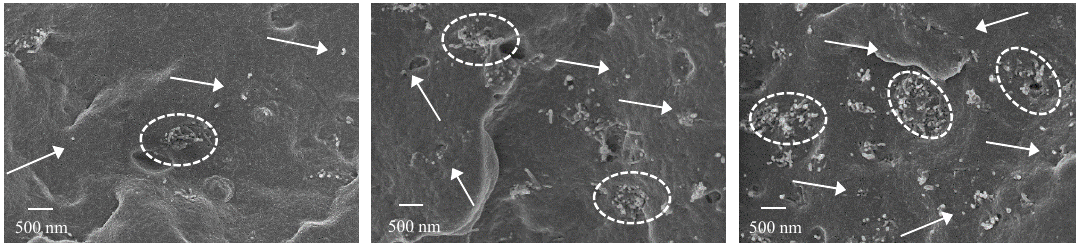
Figure 7. (a) PP/CNT ‐ 3, (b) PP/CNT ‐ 5 and c) PP/CNT ‐ 7. White arrows indicate single dispersed CNTs; white Figure 7. ( a ) PP / CNT-3, ( b ) PP / CNT-5 and ( c ) PP / CNT-7. White arrows indicate single dispersed CNTs;